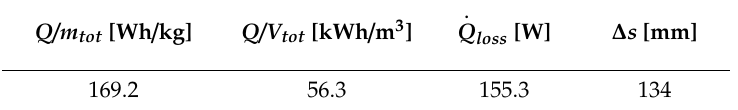
Table 6. Reference concept—central results at maximum permitted surface temperature of 60 °C.